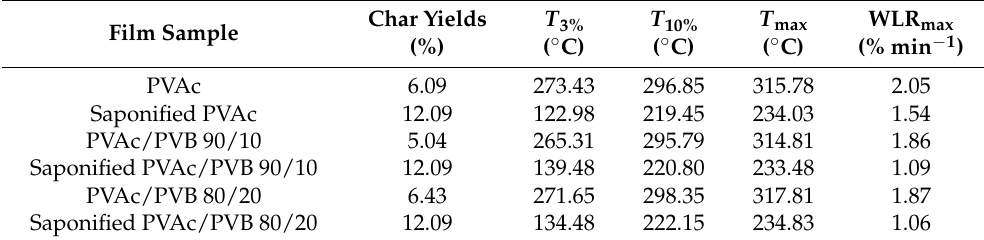
Figure 6. TGA data of unsaponified and saponified ( a ) PVAc film, ( b ) PVAc/PVB 90/10 blend film, and ( c ) PVAc/PVB 80/20 blend film (saponification temperature, 50 ◦ C; saponification time, 72 h). Table 3. TGA and DTG data of saponified and unsaponified PVAc films measured at a heating rate of 10 ◦ C min − 1 . WLR max , maximum weight loss